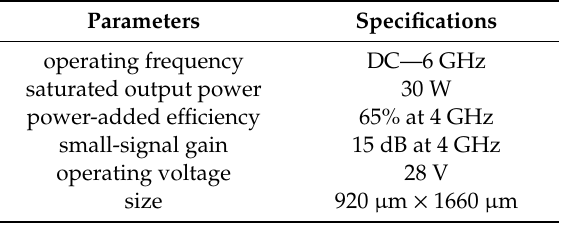
Figure 1. Photograph of a GaN high-electron-mobility transistor (HEMT) bare die (CGH60030D) from Wolfspeed.